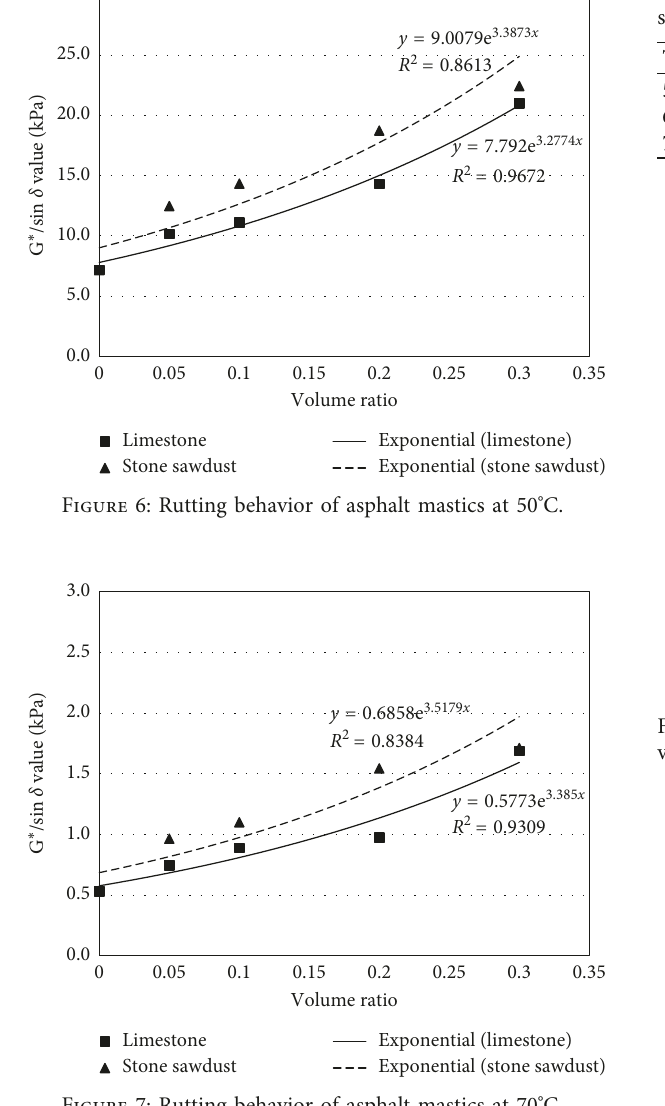
Table 5: Relationship between sawdust-asphalt